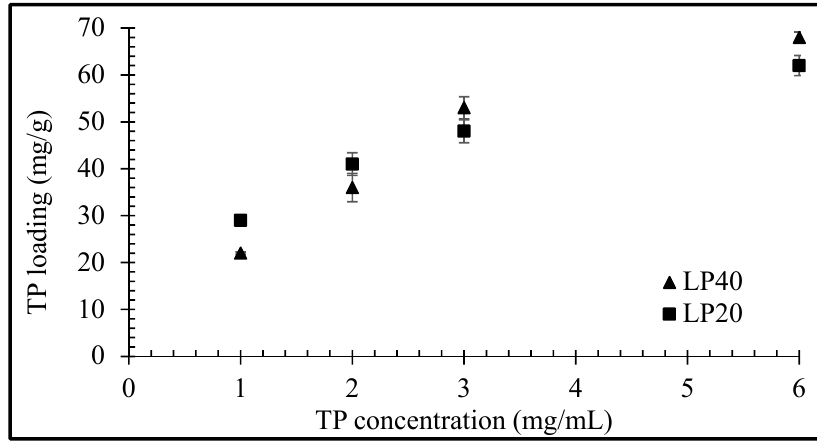
Figure 4. Equilibrium uptake of TP by LP as a function of TP concentration. Values expressed are means with standard deviations as error bars, n = 3. The rates of uptake of TP by the LP clay at pH 1.2 as functions of TP concentration are plotted in